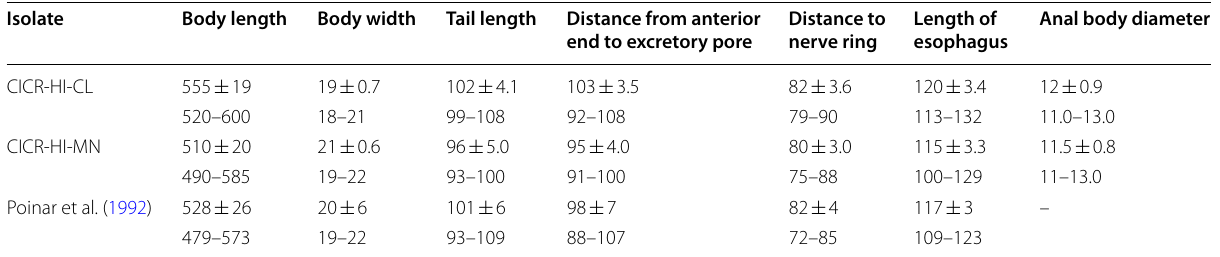
All measurements are in µm and expressed as means